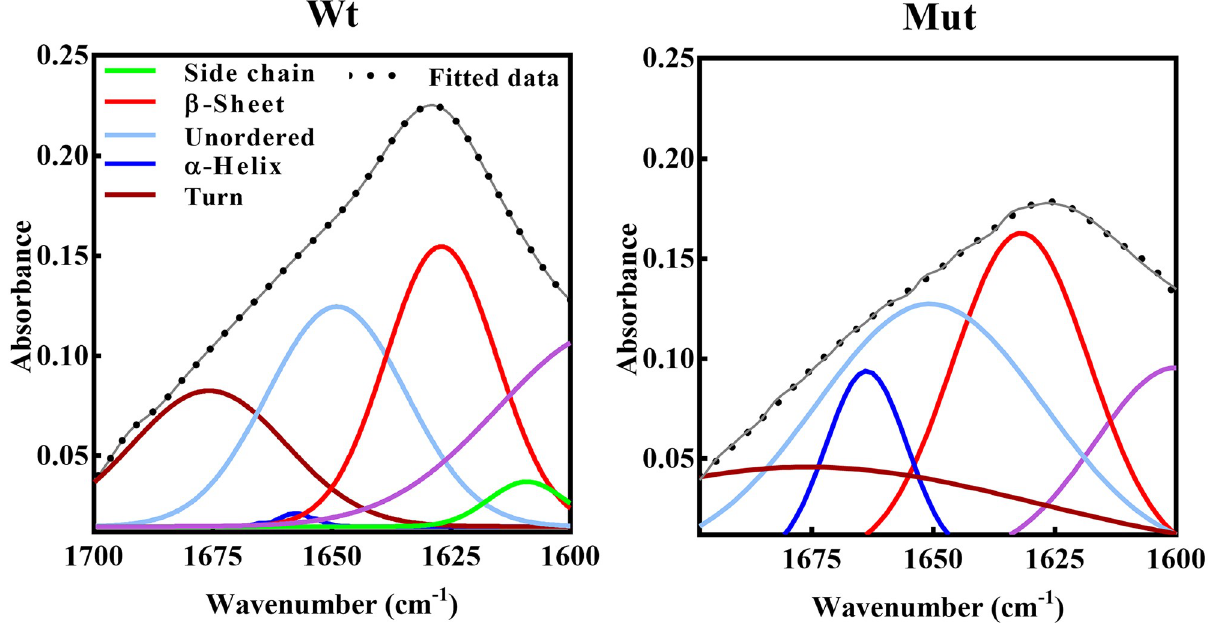
Fig 3. Protein secondary structural analysis using FTIR deconvoluted spectra. Wild-type and D109A mutant α B-crystallins spectra were recorded in the range of 1700–1600 cm -1 with a resolution of 4 cm -1 .